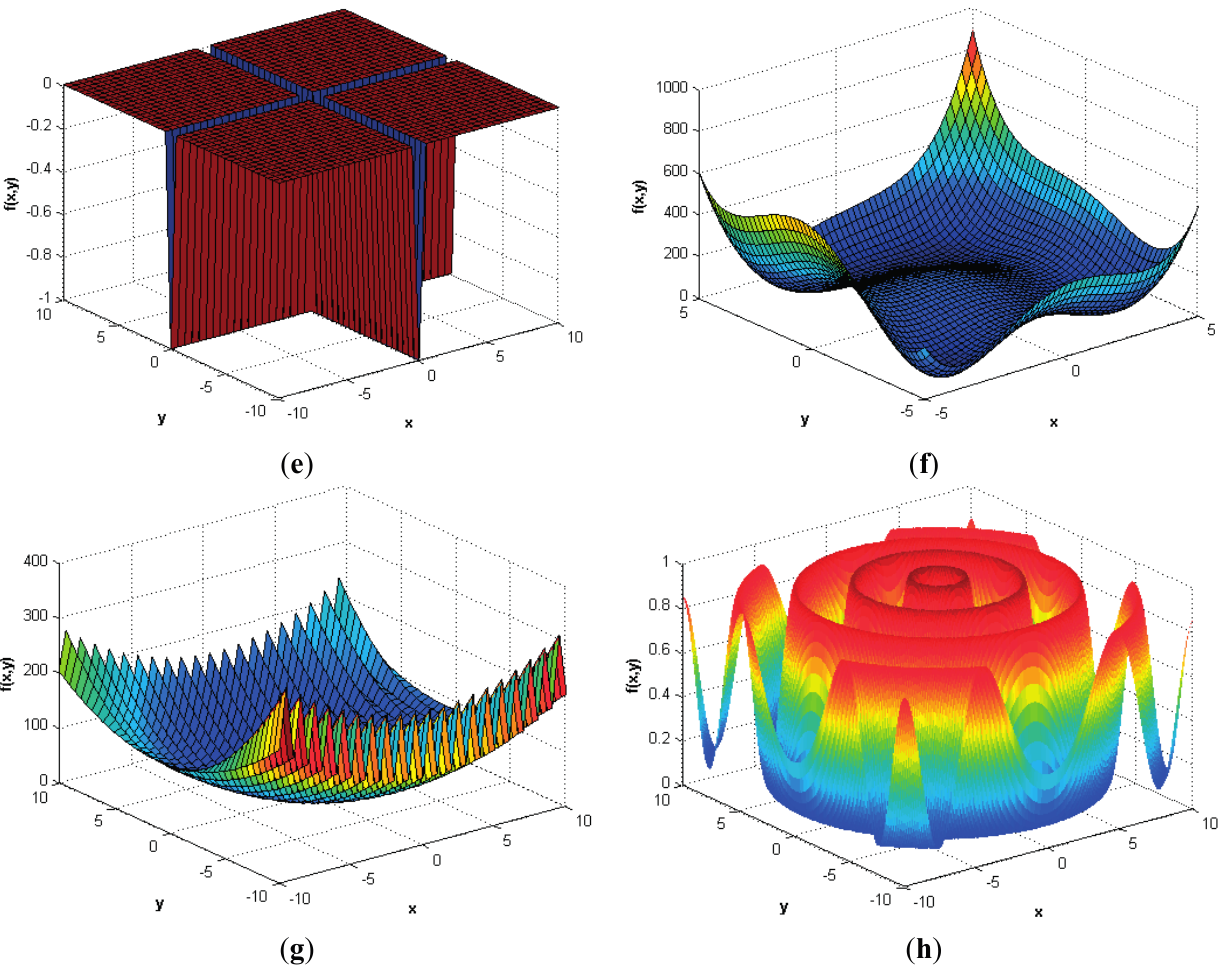
Figure 4. Surface plots of the two-variable benchmark functions used in this study: ( a ) Ackley, ( b ) Beale, ( c ) Booth, ( d ) Carrom table, ( e ) Cross-leg table, ( f ) Himmelblau, ( g ) Levy 13, and ( h )